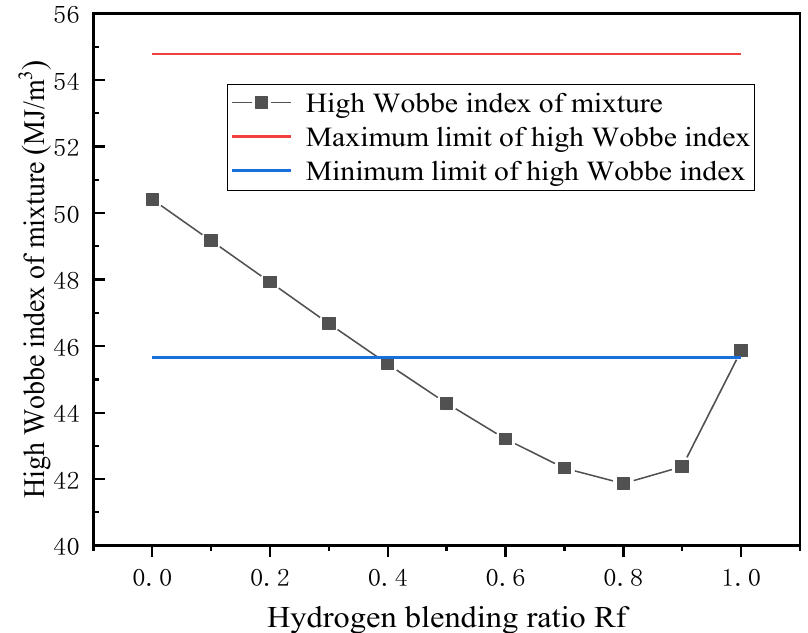
Figure 5. Calculation of high Wobbe index of mixture.